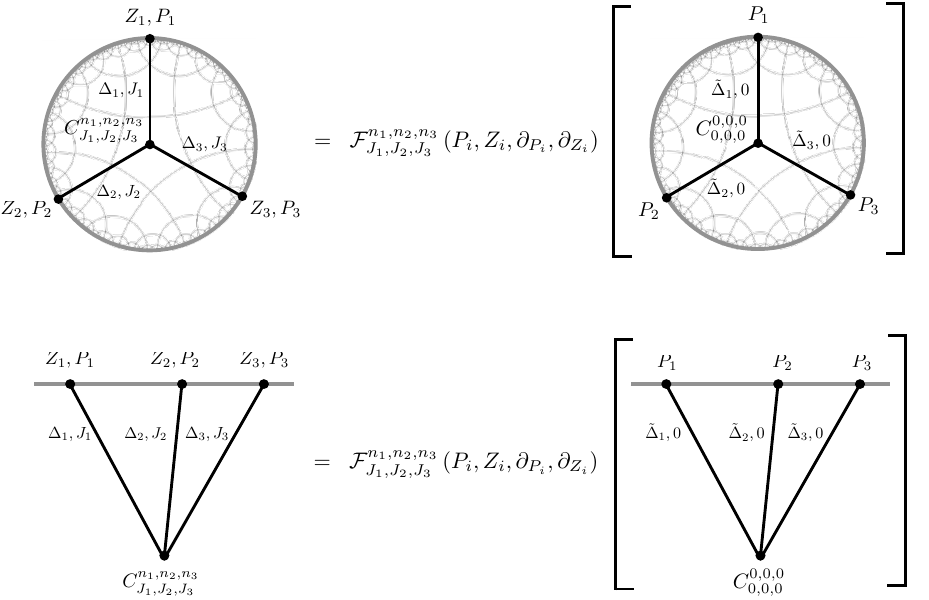
Figure 14. Spinning three-point contact diagrams in (EA)dS generated by the cubic vertex (3.53) of fields with spins J 1 - J 2 - J 2 can be generated by acting with the boundary differential operator (6.4) on a scalar “seed”, which is a three-point contact diagram generated by the non-derivative cubic interaction φ 1 φ 2 φ 3 of scalar fields with shifted scaling dimensions ˜∆ i related to the original scaling dimensions ∆ i via